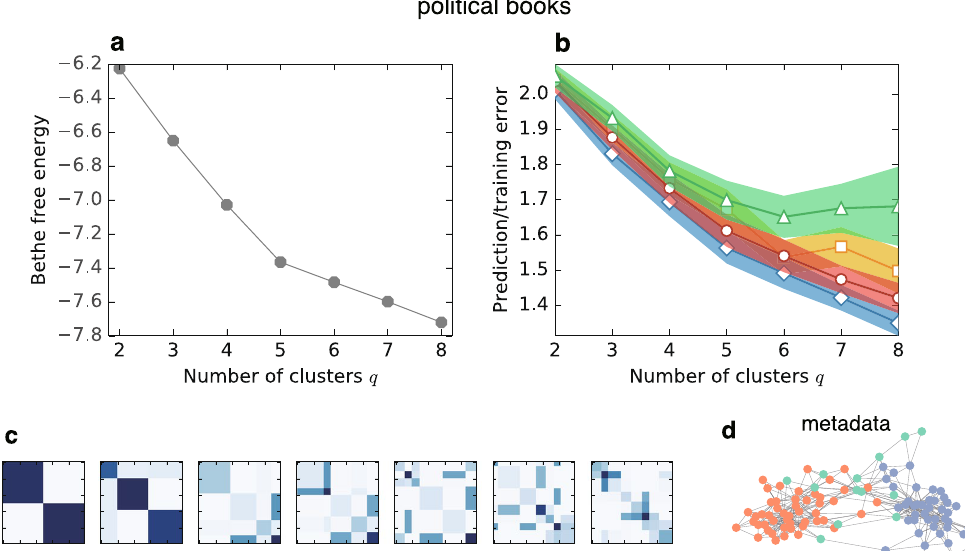
Figure 3. Model assessments and inferred clusters in the network of books about US politics. ( a ) Bethe free energy and ( b ) prediction and training errors as functions of the number of clusters q . The four data in ( b ) are, from top to bottom, Gibbs prediction errors E Gibbs (green triangles), MAP estimates E MAP of E Gibbs (yellow squares), Bayes prediction errors E Bayes (red circles), and Gibbs training errors E training (blue diamonds). For each error, the constant term is neglected and the standard error is shown in shadow. ( c ) The learned parameters, ω and γ , are visualised from q = 2 to 8. ( d ) The cluster assignments that are indicated in the metadata of the dataset; the vertices with the same colour belong to the same